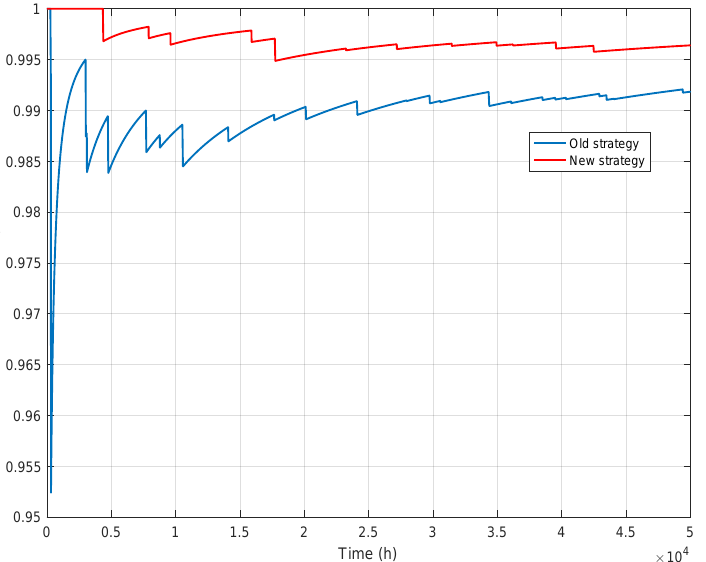
Figure 8. The plot shows the availability value of coal mills with the (“new strategy”) and without the (“old strategy”) performing remediation actions.